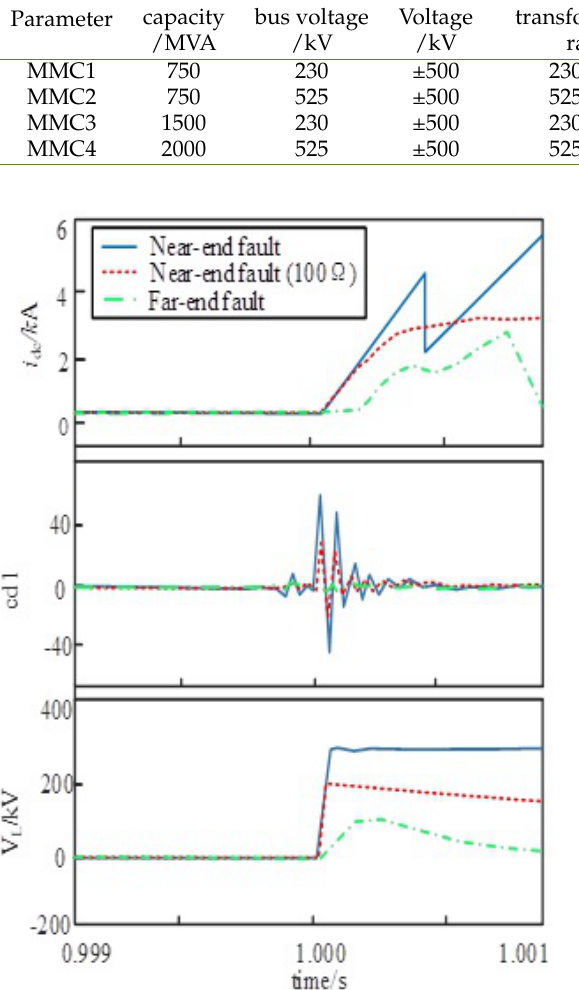
Fig. 11. Bipolar short circuit fault simulation